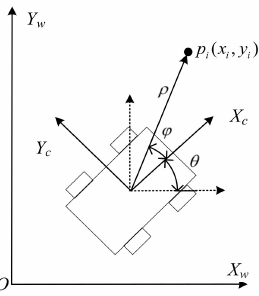
Figure 6. Laser observation model for